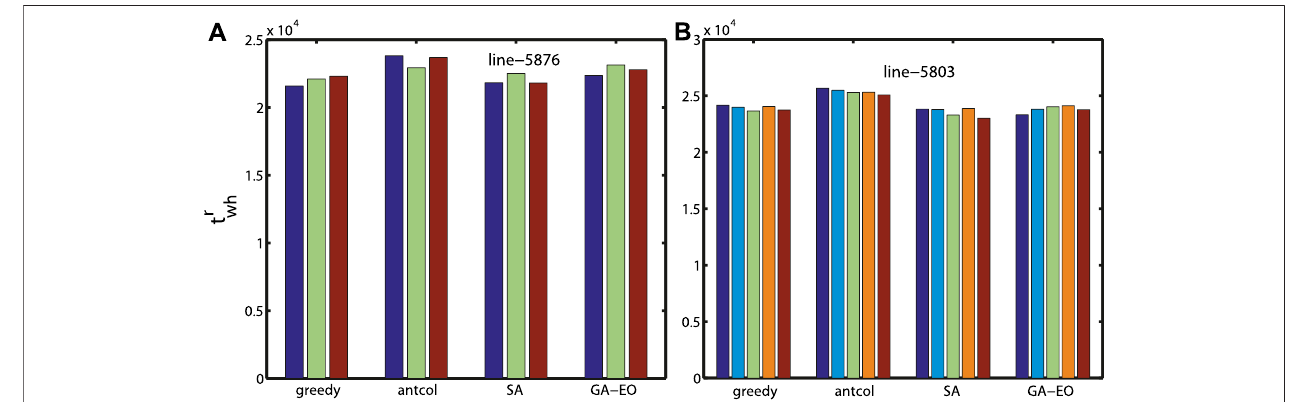
FIGURE 6 | (color online) Working hours t wh for the minimum number of inspection teams with our framework and transfer-swap algorithm. (A) k = 3 for line-5876 and (B) k = 5 for line-5803. p = 0.05 for the greedy algorithm.